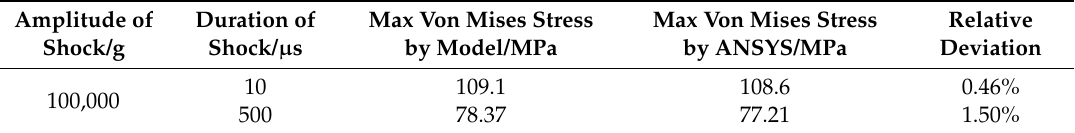
Figure 16. Maximum deformation as calculated by ANSYS and the proposed model versus shock load amplitude. Table 4. Maximum Von Mises equivalent stresses of the inductor with double auxiliary pillars as calculated by ANSYS and the proposed model.